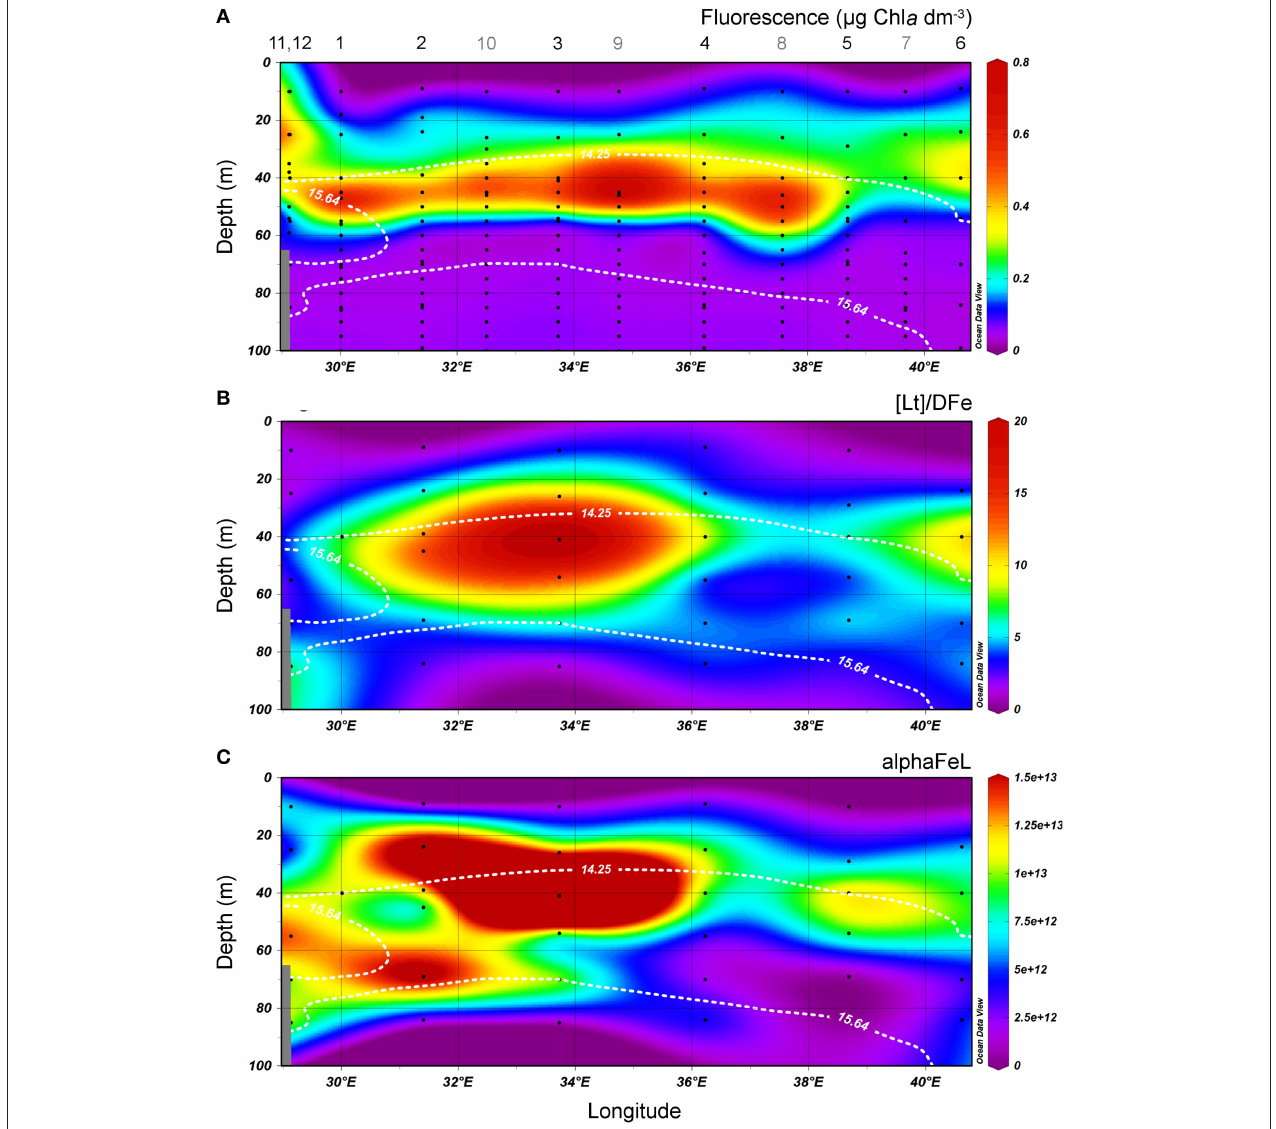
FIGURE 4 | Transects of the cruise track of the upper 100m from East to West. The upper boundary of the oxycline and its lower boundary (i.e., the OL-suboxic interface) at σ 2 = 14.25kg m − 3 and 15.64kg m − 3 , respectively, are indicated by white dotted lines. (A) Fluorescence ( µ g Chl α dm − 3 ) from calibrated CTD sensor data. (B) the ratio [L t ]/DFe. (C) alphaFeL. (B,C) are both dimensionless. All data points are shown. Stations numbers are indicated above transect A. Note that more stations (indicated with gray numbers) were sampled for fluorescence. In samples where two ligands could be discriminated, the data of the two